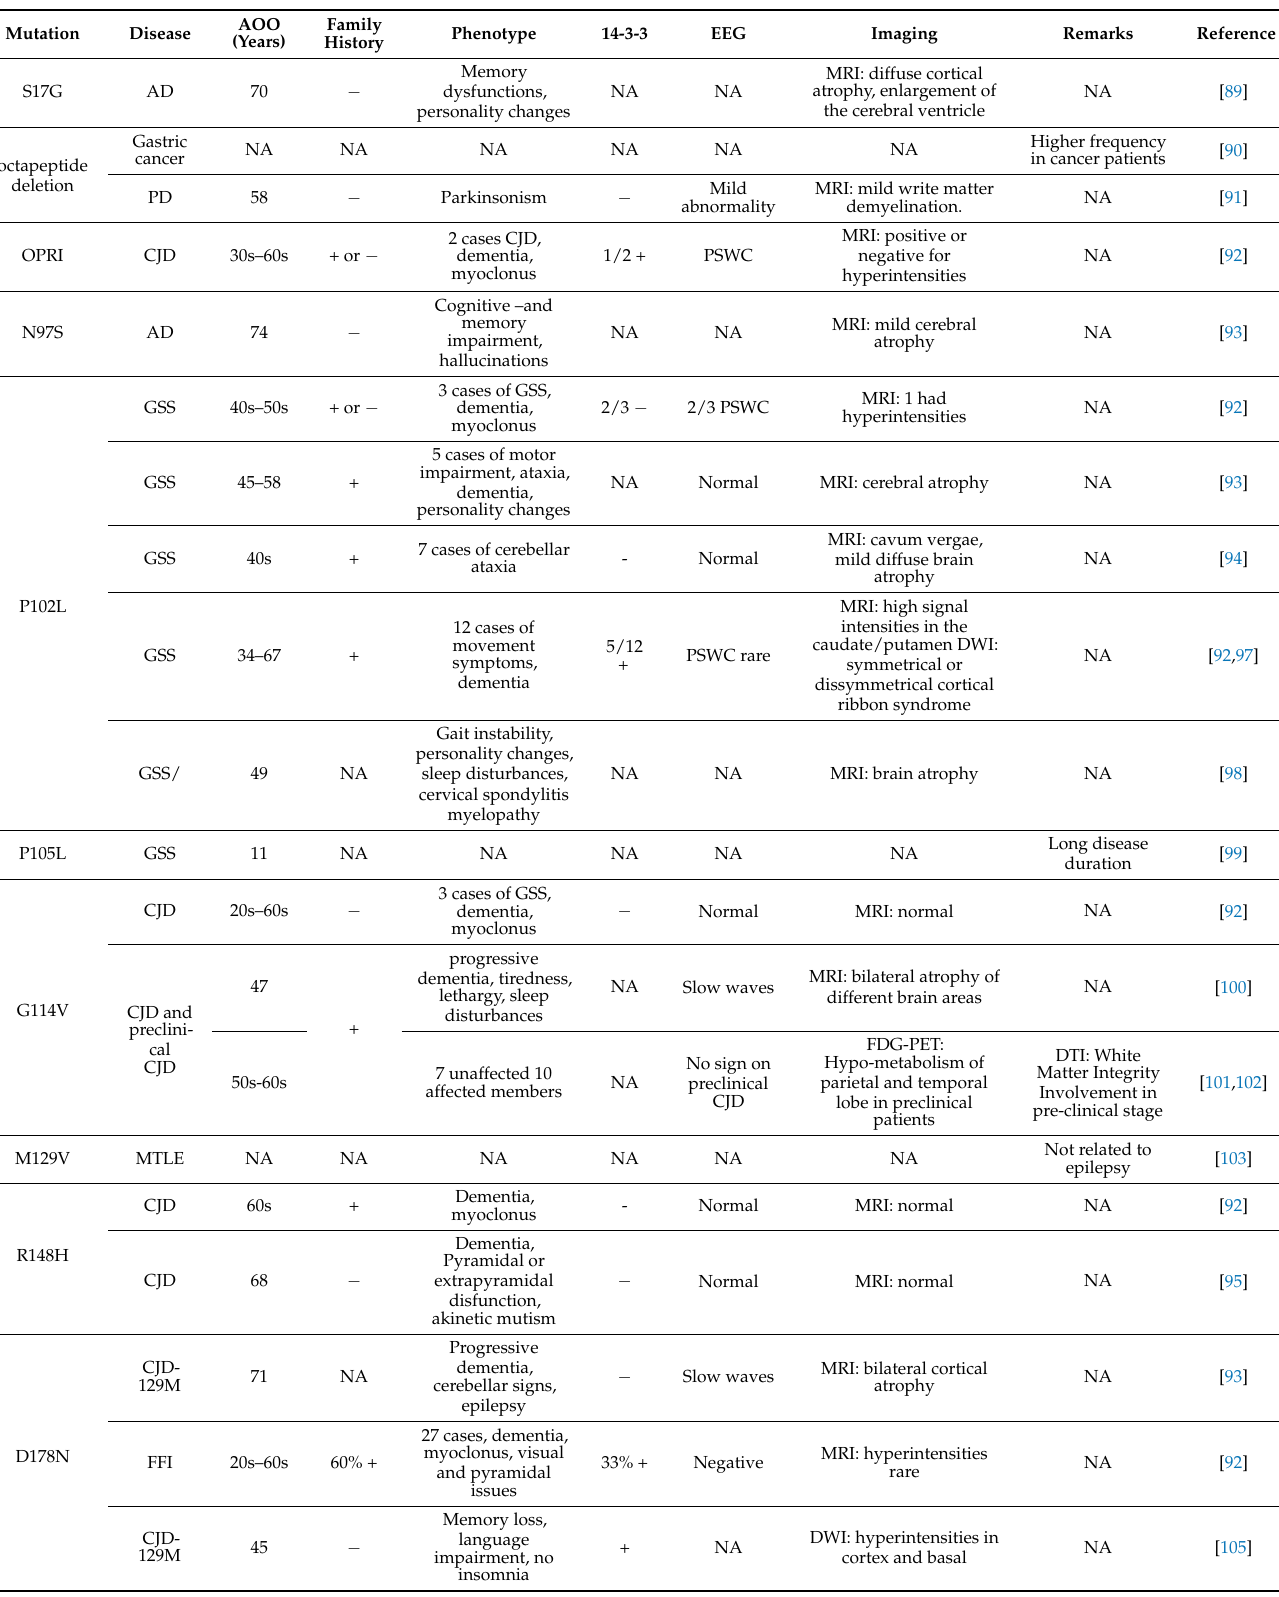
Table 3. Prion mutations found in Chinese